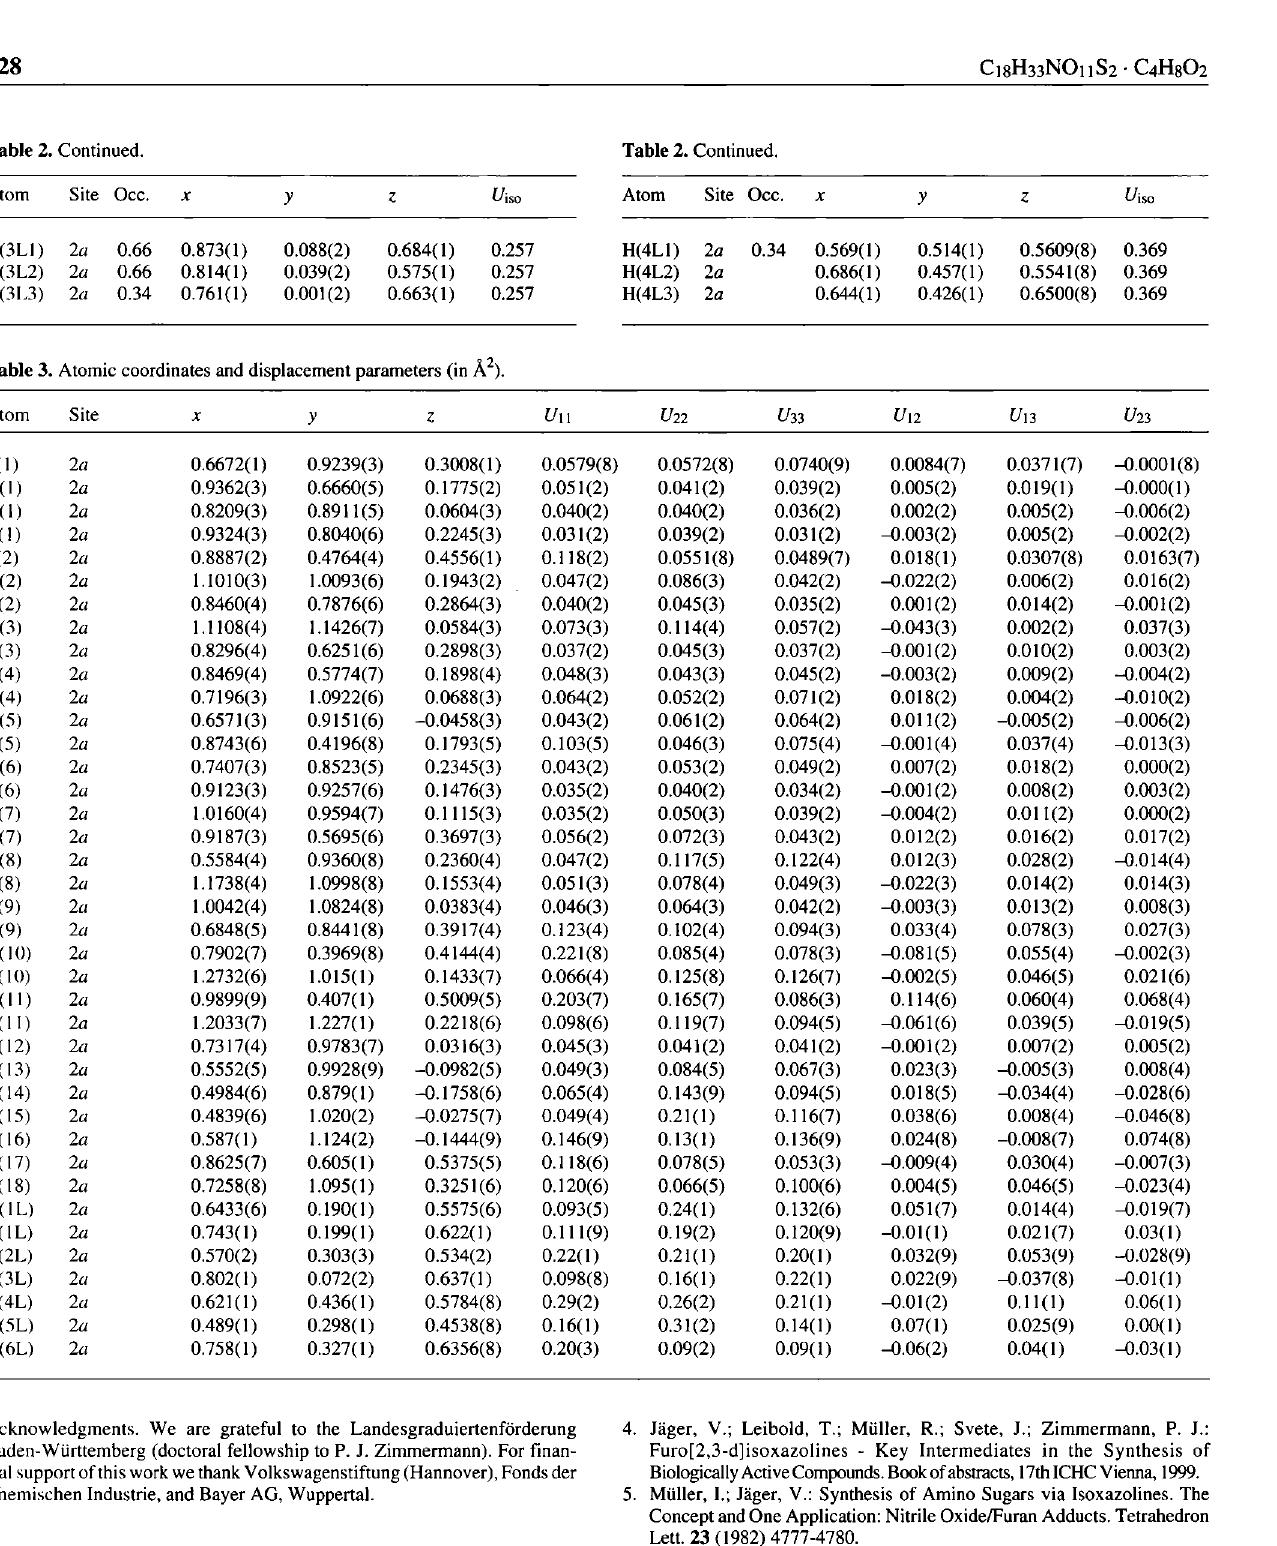
Table 3. Atomic coordinates and displacement parameters (in Ä 2